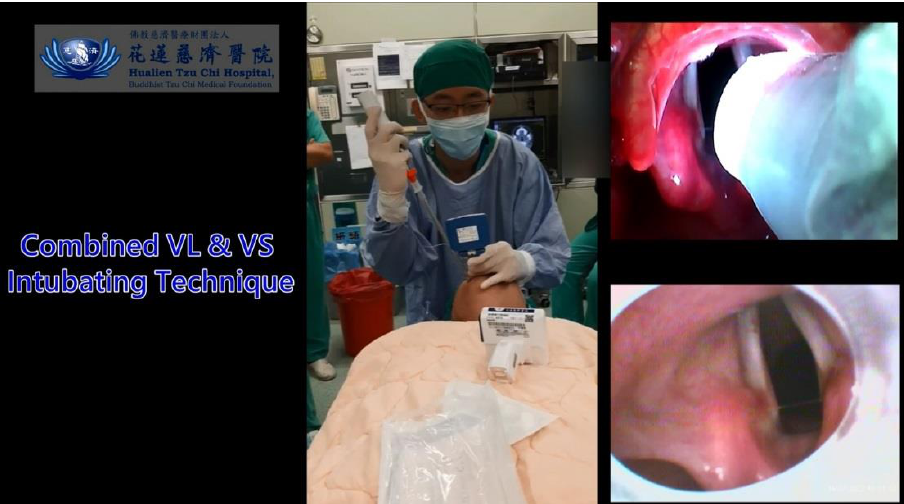
Figure 2. A demonstration video clip showing the video-twins technique. A 24-year-old man with BMI 21.4 kg/m 2 (183 cm, 72 kg). The airway operator holds a videolaryngoscope in his non-dominant hand and maneuvers a video-assisted intubating stylet in his dominant hand. The Cormack-Lehane class I, POGO 100%, and intubation time by intubating stylet is 15 s (from lip to trachea). (Also, see the Supplementary Materials-Video S1). Intubating devices: Trachway and UE.